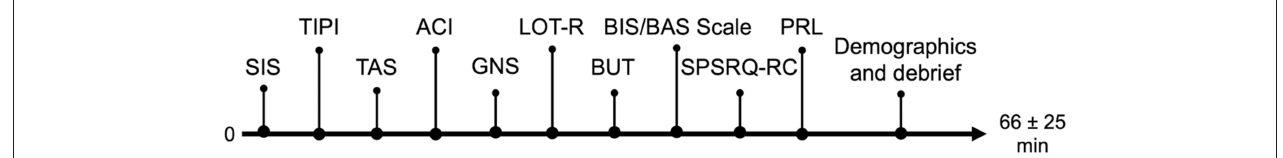
FIGURE 7 | Schematic representation of the testing procedure. The tests were completed in the following order: SIS, Susceptibility to (mis)information scale; TIPI, Ten item personality inventory; TAS, Trait anxiety scale; ACI, Ambiguous cue interpretation test; GNS, Grandiose narcissism scale; LOT-R, Life orientation test revised; BUT, Belief updating test; BIS/BAS Scale, Behavioral Inhibition System/Behavioral Approach System scale; SPSRQ-RC, Sensitivity to punishment Sensitivity to reward questionnaire revision and clarification; PRL, Probabilistic reversal learning, and Demographic survey followed by a debrief.